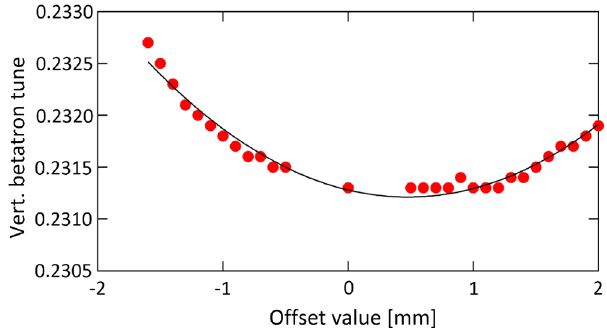
FIG. 17. Vertical betatron tune versus offset: (filled circle): experimental vertical tune measurement, (line): fitting